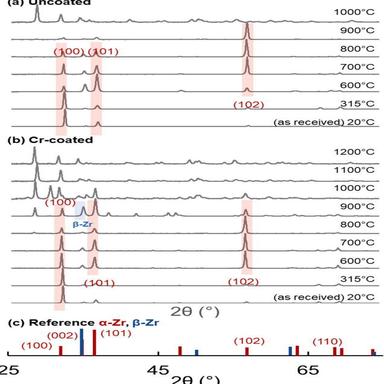
Normalized XRD patterns for (a) uncoated Zr-alloy; (b) Cr-coated OPZ post quenching; (c) reference for powder α-Zr with select crystallographic planes labelled and for powder β-Zr.